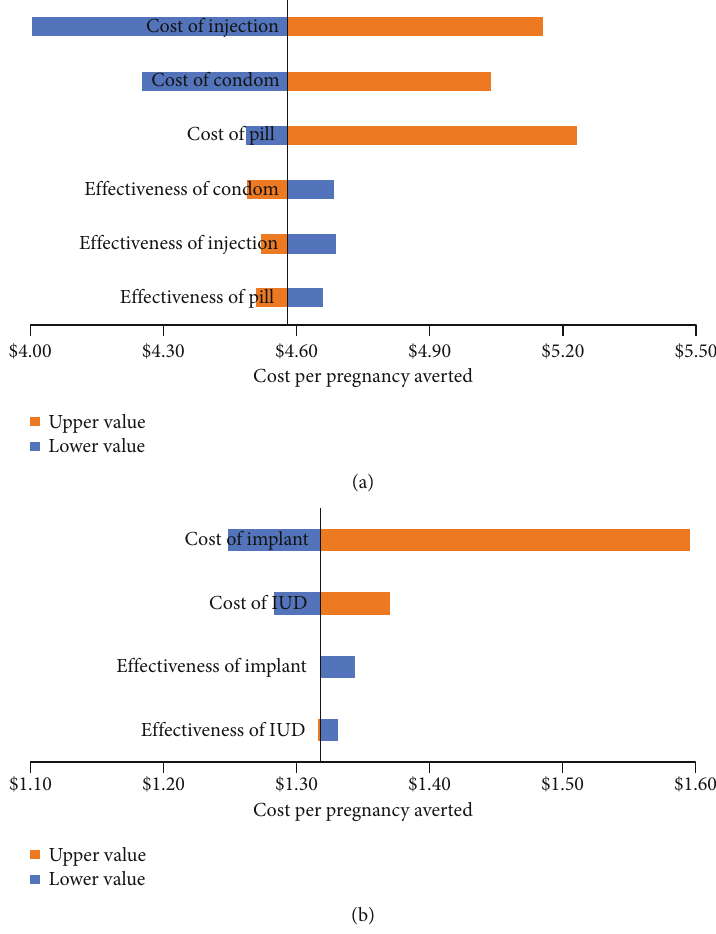
Figure 3: (a) One-way sensitivity analysis of SARC. (b) One-way sensitivity analysis of